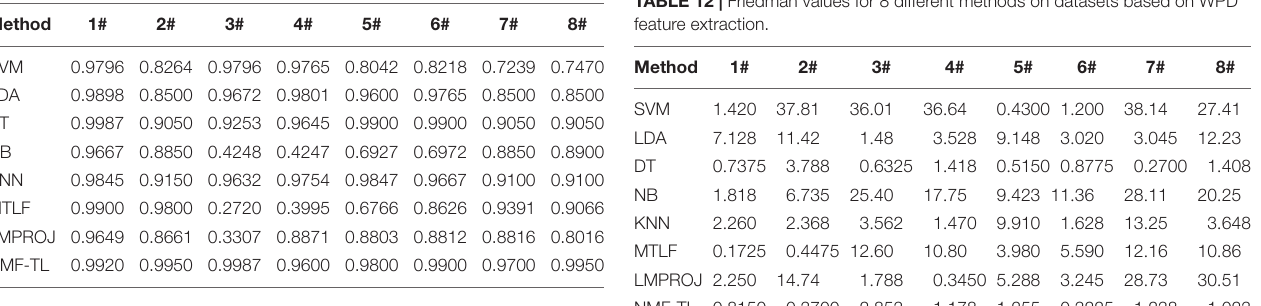
TABLE 9 | Recall of 8 classifiers on datasets based on WPD feature extraction. Method